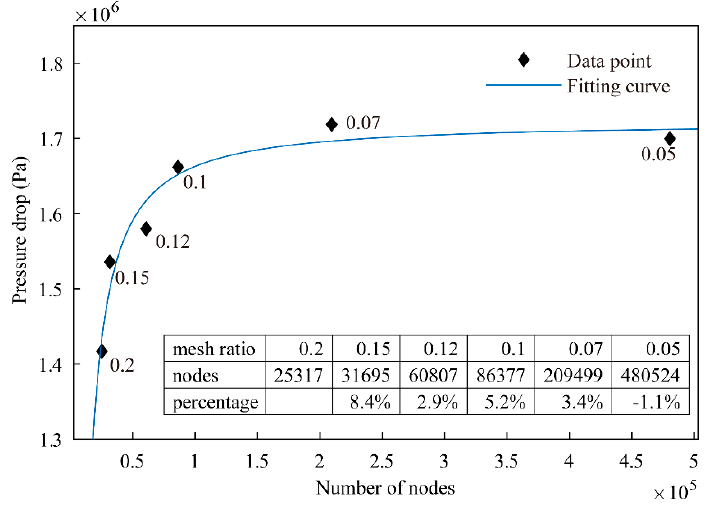
Figure 3. Sensitivity of mesh.